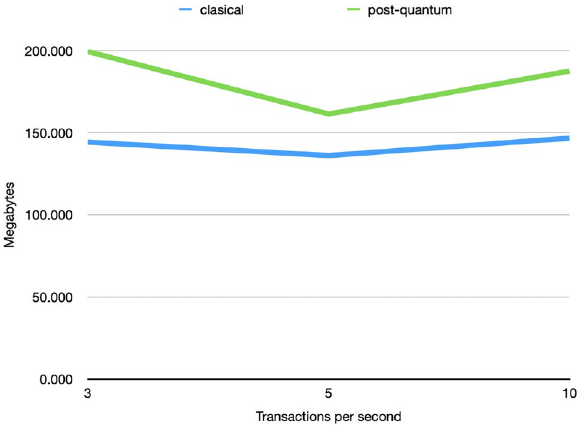
Figure 14. Comparison between the average use of memory in the classical and post-quantum scenarios when sending 3, 5, and 10 tx/s.